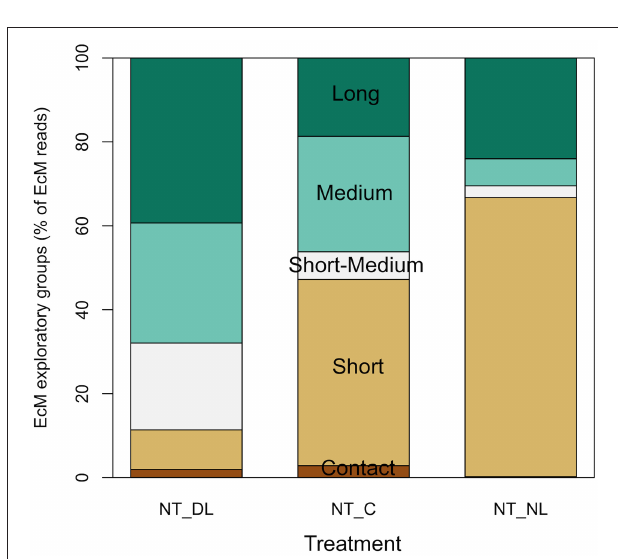
FIGURE 6 | Shifts in the relative abundances of ectomycorrhizal fungi groups of different exploratory strategies for each leaf litter input treatment. Only abundances of ectomycorrhizal fungi in Non-Trenched plots are presented, since the root trenching suppressed virtually all ectomycorrhizal fungi. NT_DL, Non-Trenched and Doubled Litter; NT_CL, Non-Trenched and Control Litter; NT_NL, Non-Trenched and No-Litter; T_DL, Trenched and Doubled Litter; T_CL, Trenched and Control Litter; T_NL, Trenched and No-Litter.